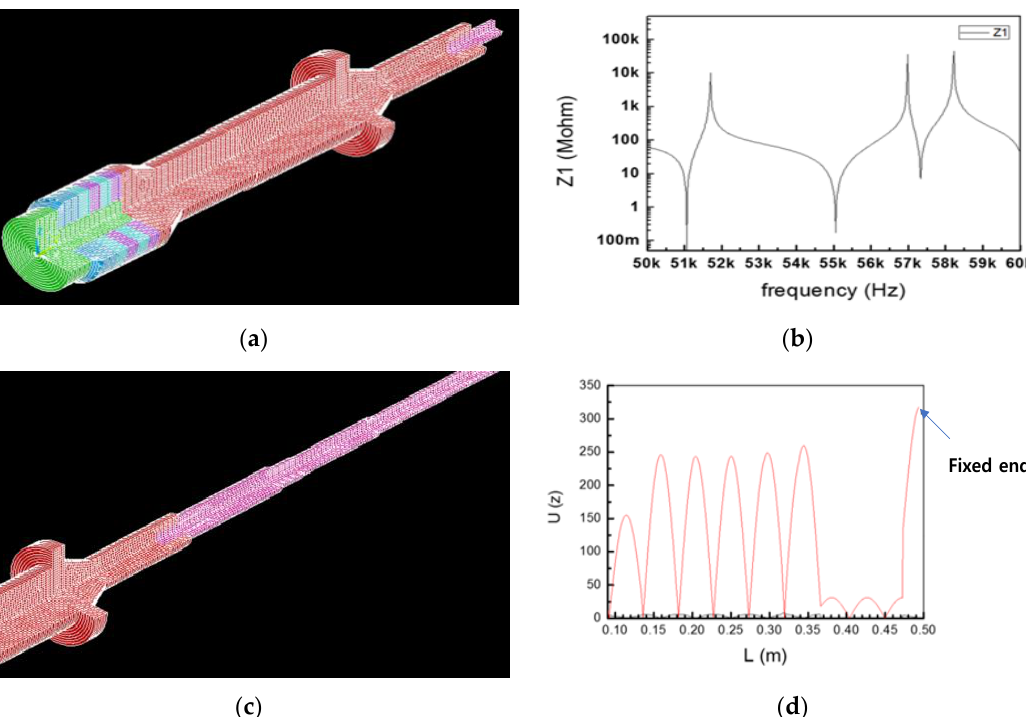
Table 2. Measured input and output amplitudes of the main control circuit with error rates.